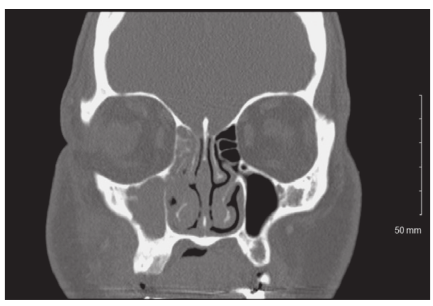
Figure 1: Computed tomography